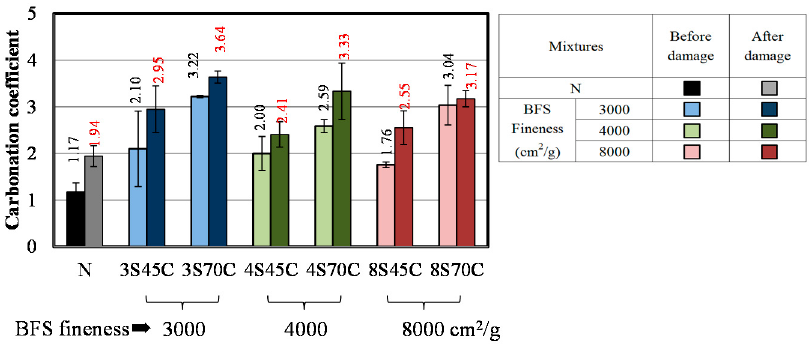
Figure 10. Carbonation coefficients of different mortar samples after damage.